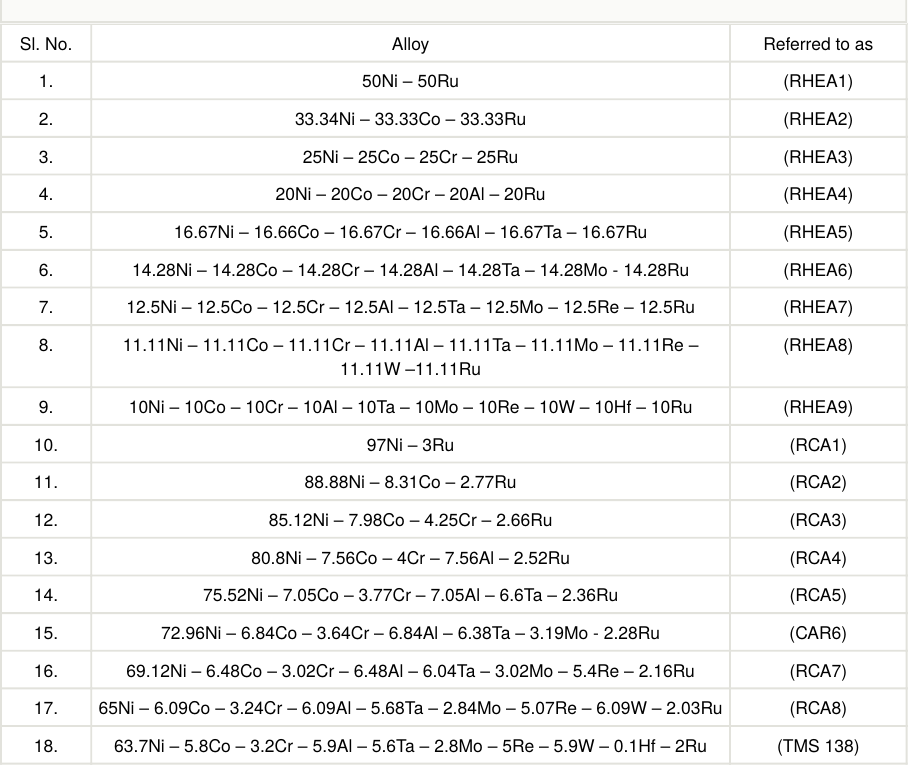
Design of alloy compositions containing ruthenium. *RHEA – High entropy alloy with Ruthenium, *RCA – Conventional alloy with